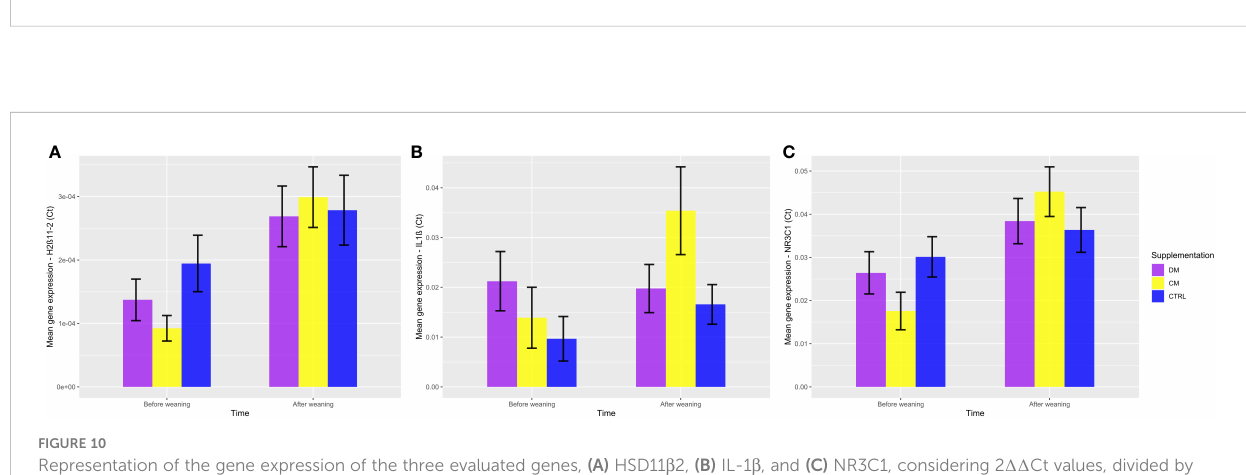
FIGURE 9 Analysis of the gene expression of the three evaluated genes (A) HSD11 b 2, (B) IL-1 b , and (C) NR3C1, considering 2 ΔΔ Ct values. Comparison between milk supplementation DM (Asinine milk), CM (Cow skimmed milk), and CTRL (Control without supplementation) in the post-weaning period. Data represent averages ± standard error of the mean (SEM). Statistical description: ns (not signi fi cant, p > 0.05); * (signi fi cant, p < 0.05).